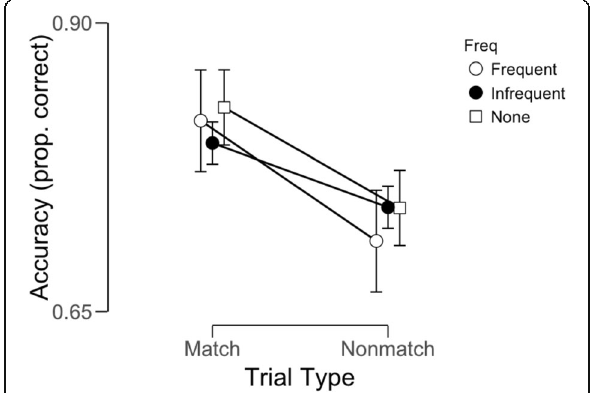
Fig. 4 Match and nonmatch accuracy for age-matched participants with varied weekly ID verification frequency. Error bars represent 95%